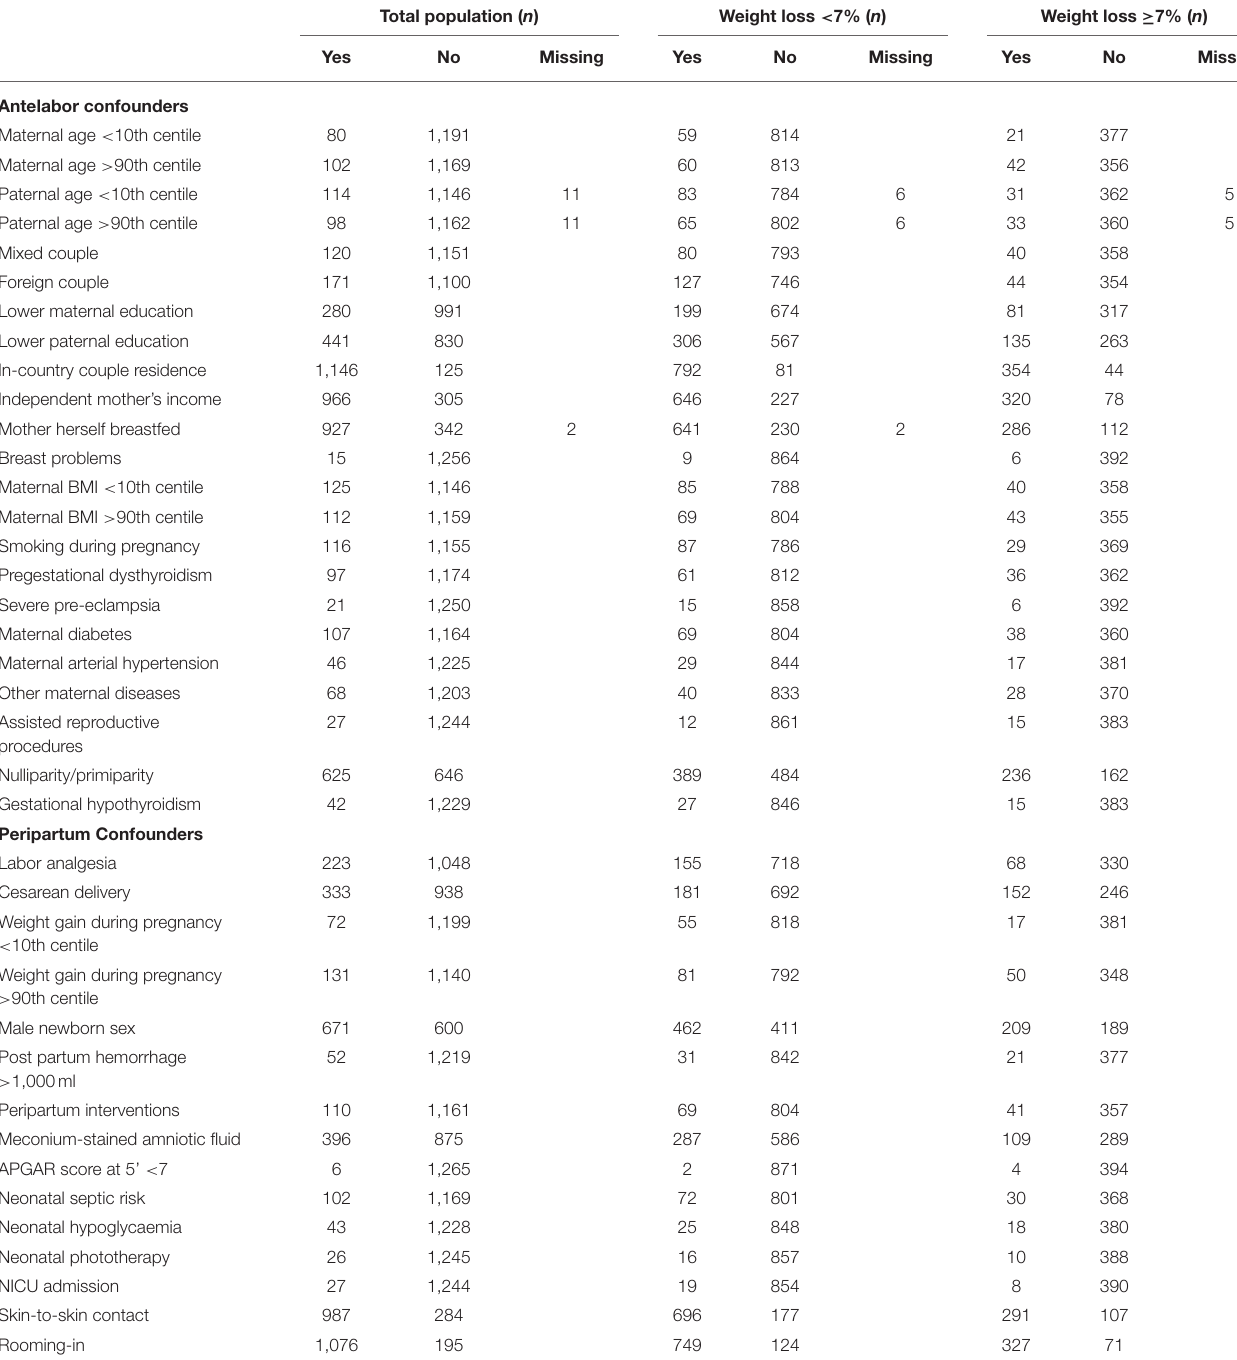
TABLE 1 | Antelabor and peripartum confounders analyzed, and number of missing